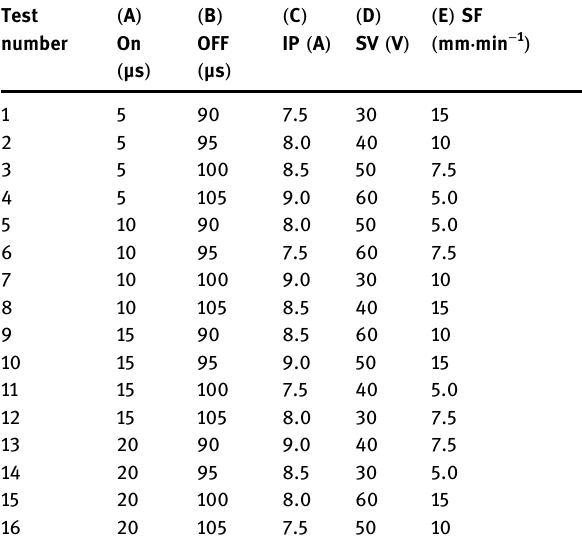
Table 2: Orthogonal test factors and levels Levels ( A )